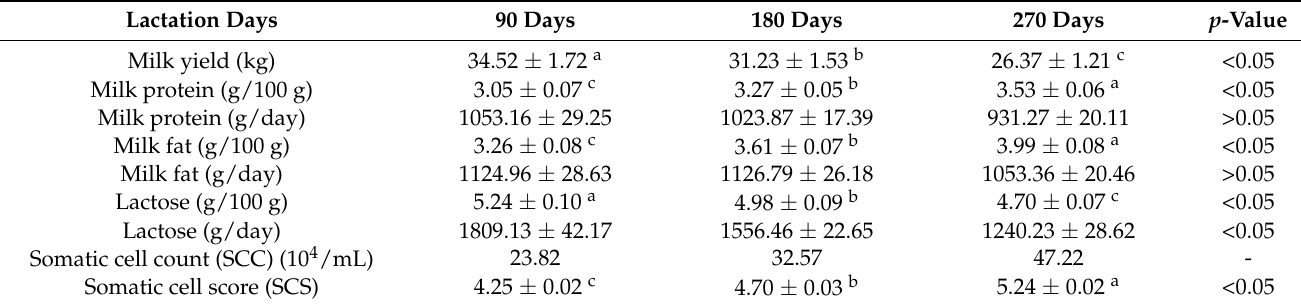
Table 1. Milk yield, milk composition, and somatic cell count of the three cows at the 90th, 180th, and 270th day after lactation (mean ± SD).